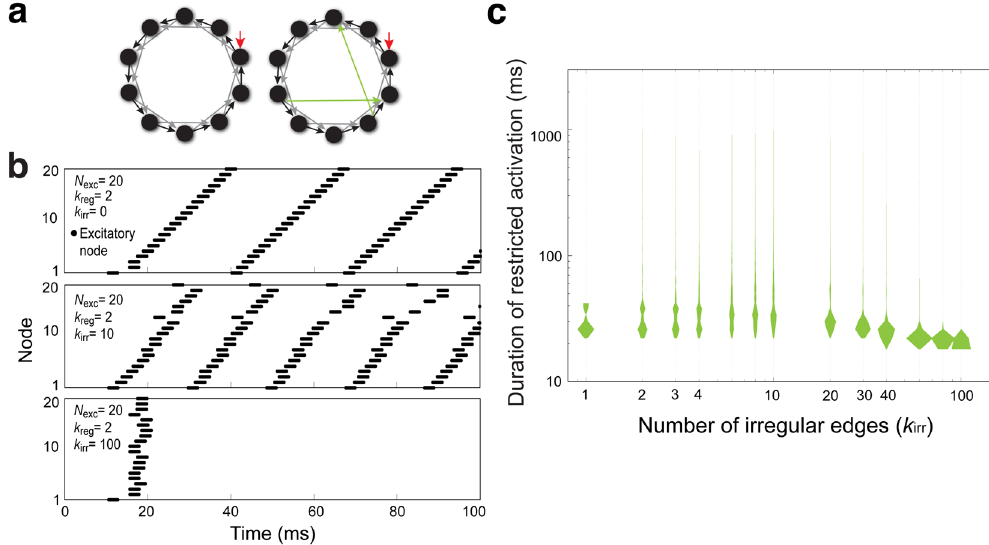
Figure 7. Attaching additional edges to the excitatory LN network to simulate LN variability. ( a ) Diagram depicting the random addition of edges to the basic regular network. Left : basic regular network, in which the number of irregular edges ( k irr ) is 0. Right : a network structure with two additional irregular edges (green, k irr = 2). Two additional directed edges are randomly attached to two excitatory nodes, and randomly connected to two other nodes. ( b ) The dynamics of network activation are shown as spike raster plots. Top : When k irr = 0, the network showed ceaseless and regular activation patterns. Middle : when k irr = 10, some simulated networks show irregular and restricted activation patterns over time (example trace, 106.03 ms). Bottom : when k irr = 100, the simulated networks showed irregular and restricted activation patterns with very short duration of activation (example trace, 20.96 ms). ( c ) The durations of restricted activation (green, ∈ [15,1000]) are shown as violin plots. When k irr = 0, none of the simulated network structures exhibited restricted activation, and these data are not shown on the plot. A statistically significant difference was identified among groups by the Kruskal- Wallis H -test ( p < 0.0001) (Table